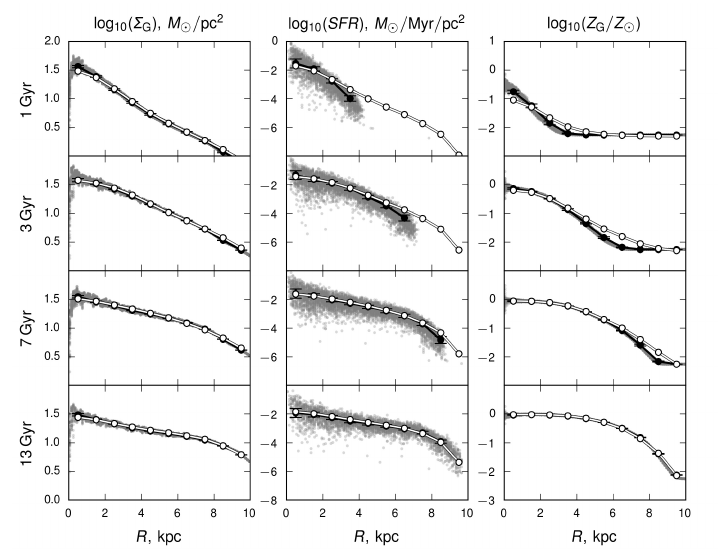
Fig. 5. Radial profiles of the gas surface density, SF surface density and metallicity at different time. The white circles indicate a smooth SF 1-D model. The black dots indicate the mean values of eight independent runs of the LS model averaged within 1 kpc wide rings; the error bars show the standard deviations in the scatter of the model values. The gray dots indicate the LS models averaged within 0.1 kpc wide rings. The time bin for averaging was 100 Myr.